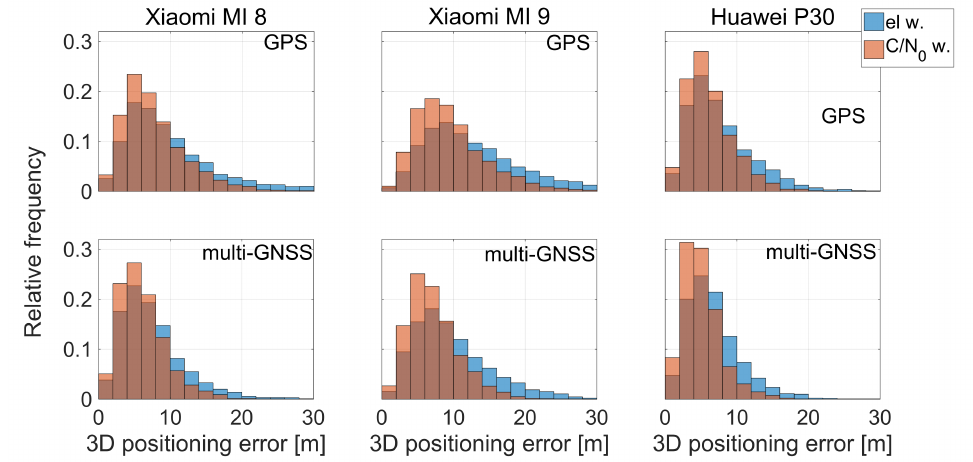
Figure 10. Three-dimensional coordinate error histogram for GPS and multi-GNSS solutions. The results achieved with the elevation-dependent weighting scheme are represented in blue while those obtained with C / N 0 weighting are represented in red. Each bin is 2 m wide. Xiaomi Mi 8, Xiaomi Mi 9, and Huawei P30 smartphones are shown in the left, middle and right columns, respectively. A cut-off threshold of 30 m is used to achieve a better visibility of higher probability